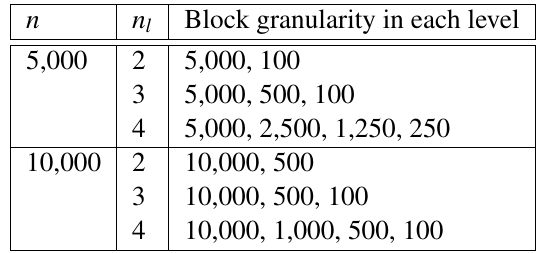
Table 1 Configurations for the experimental evaluation of the H − Cholesky